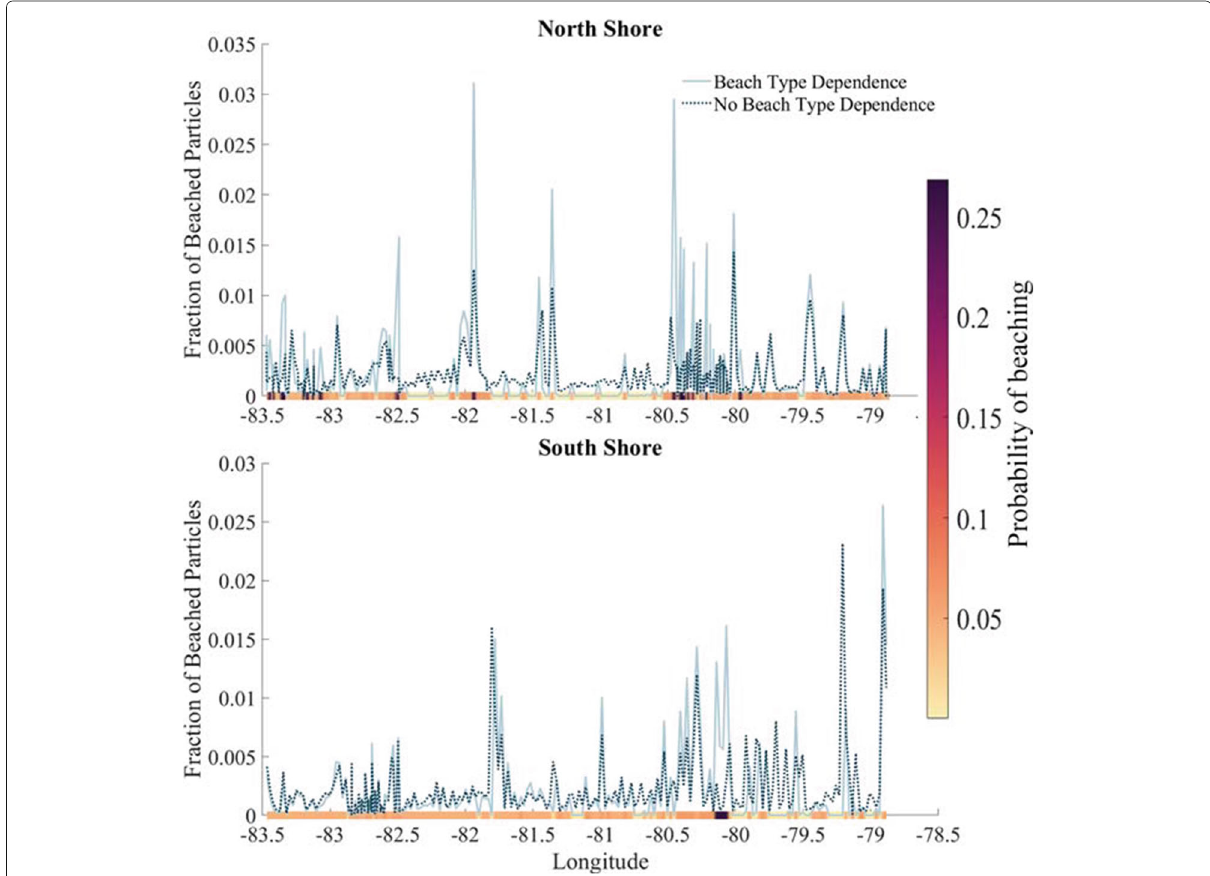
Fig. 5 Number of particles beached on the North and South shores for the model with and without beach type dependence. For the model with beach type